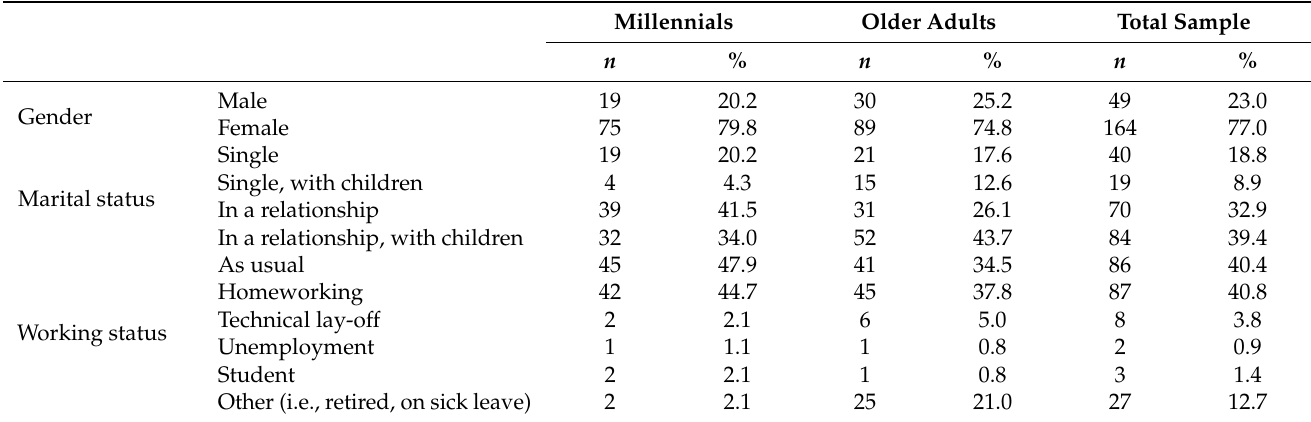
Table 1. Sociodemographic characteristics.